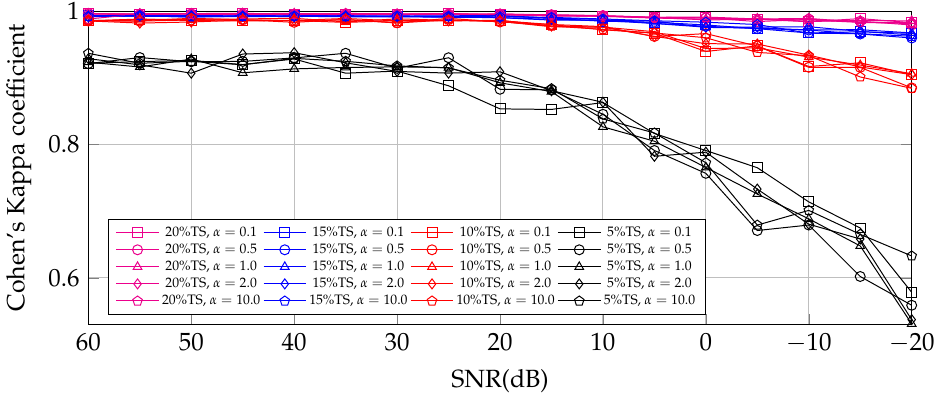
Figure 17. Indian Pines. Cohen’s Kappa coefficient obtained using 3DCNN DL model trained with 20%, 15%, 10%, and 5% of the samples of compressed IP HSI for different α values. α -values do not seem to influence Cohen’s Kappa coefficient.